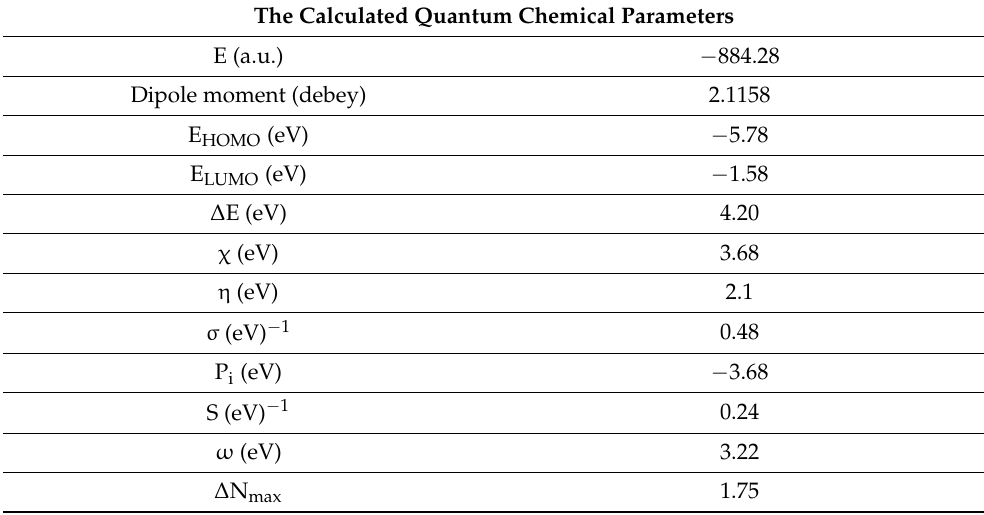
Table 3. The different quantum chemical parameters of the free acetyl ferrocene imine ligand. The Calculated Quantum Chemical